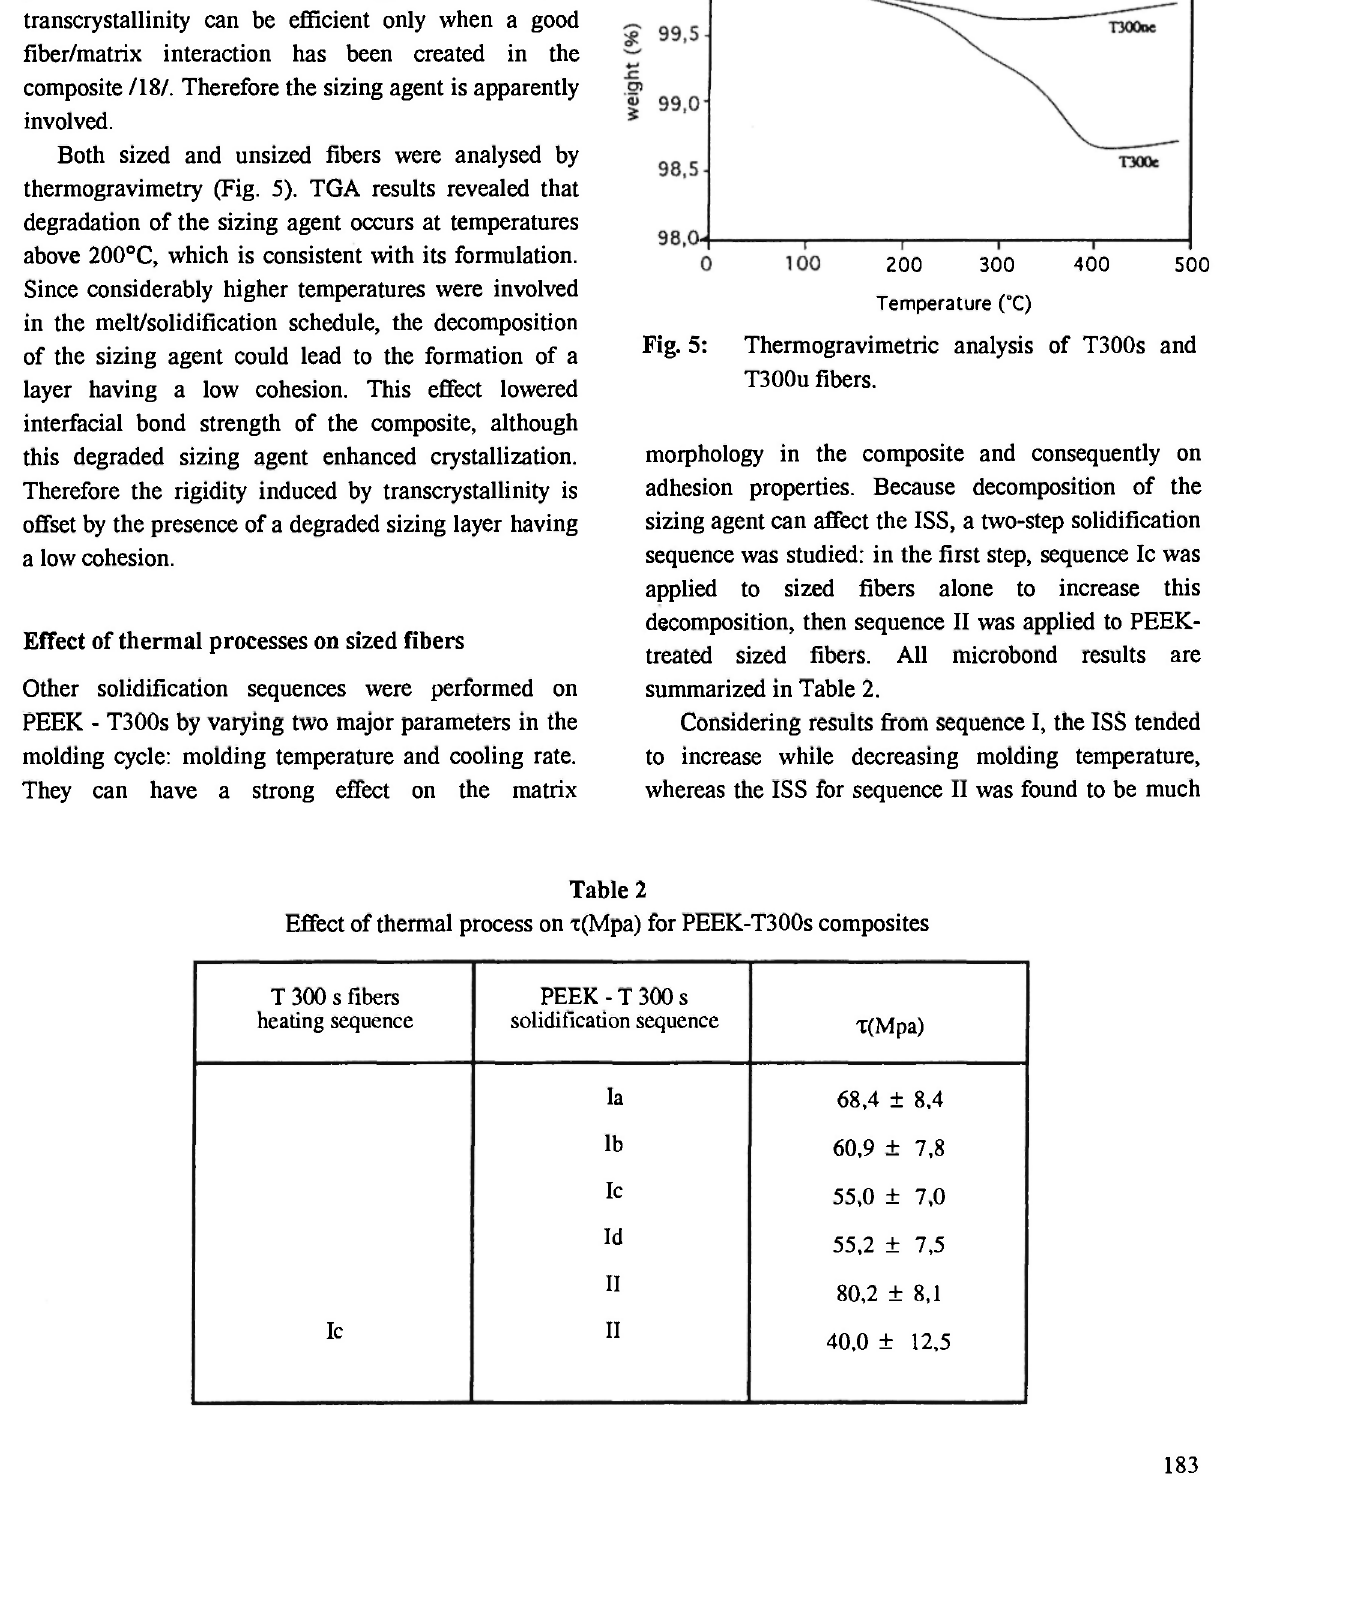
Fig. 5: Thermogravimetric analysis of T300s and T300u